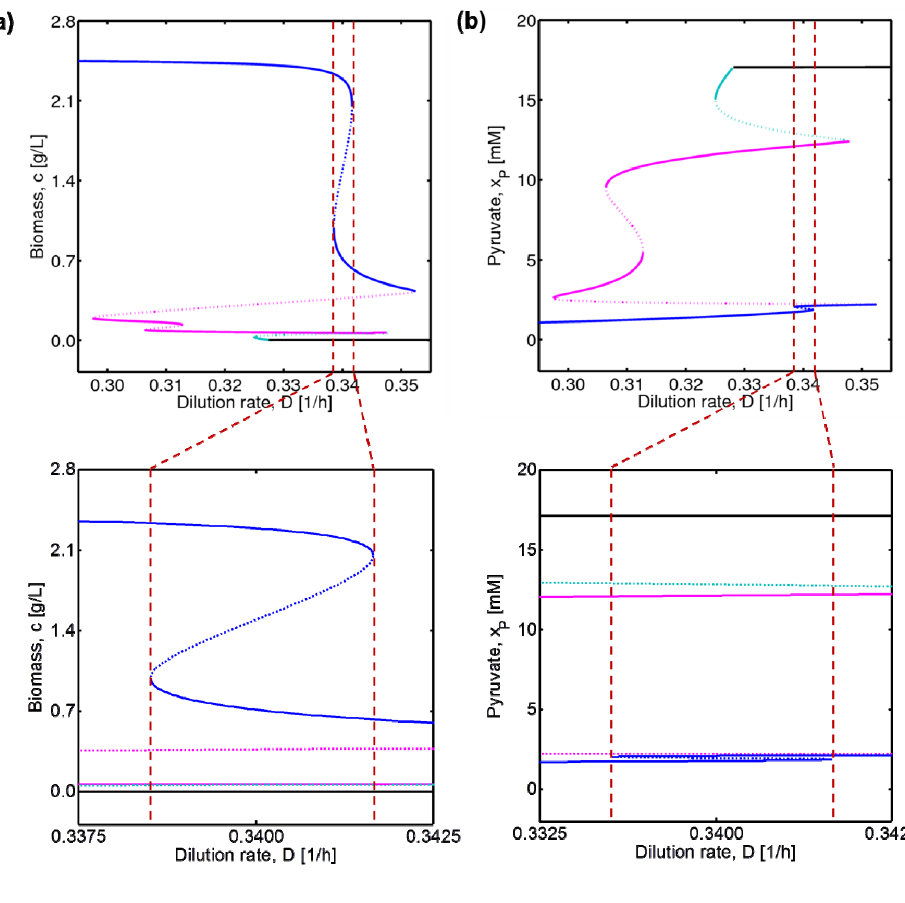
Figure 9. Hysteresis curves of all components when γ =